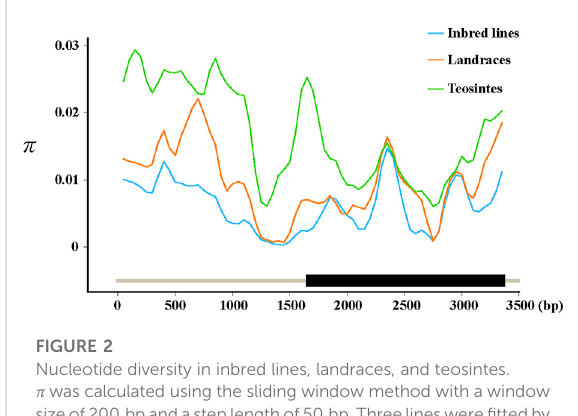
FIGURE 2 Nucleotide diversity in inbred lines, landraces, and teosintes. π was calculated using the sliding window method with a window sizeof200 bpandasteplengthof50 bp.Threelineswere fi ttedby locally weighted regression (Loess) in R software. The parameter controlling the degree of smoothing was set as 0.1.